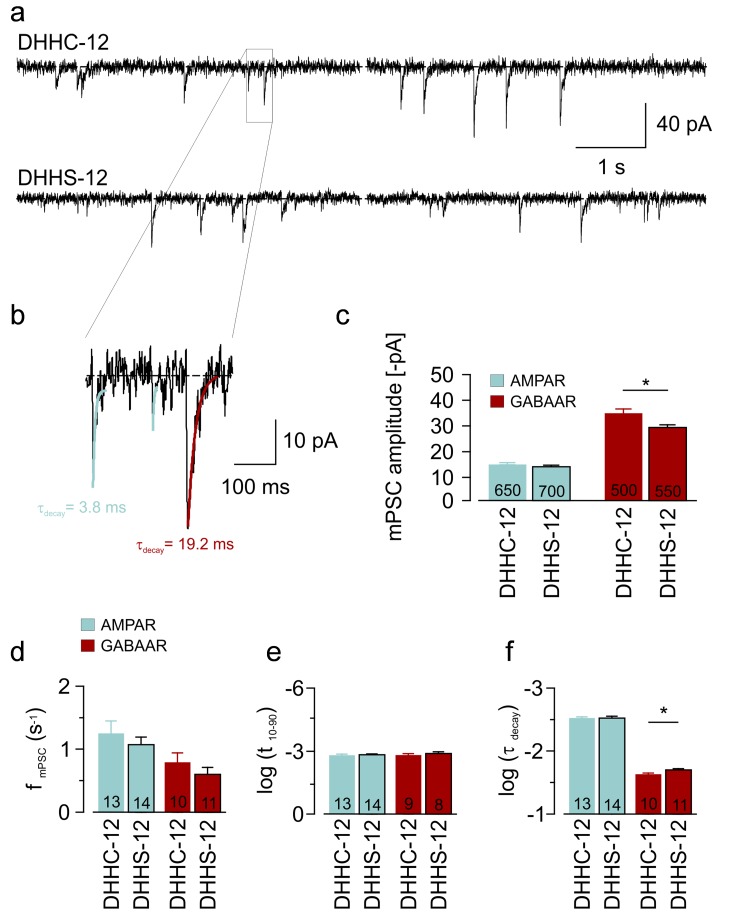
Electrophysiological analysis of GABAergic and glutamatergic mPSCs.(a) Example traces showing mPSCs recorded from DHHC-12– and DHHS-12–expressing neurons (identified using bicistronic mCherry expression). AMPAR- and GABAAR-mediated mPSCs were distinguished according to fast (AMPAR) and slow (GABAAR) decay kinetics. (b) The zoomed region of a recording from a DHHC-12–expressing neuron illustrates exponential fits of the different decay time constant (gray, AMPAR, τ = 3.8 ms; red, GABAAR, τ = 19.2 ms). (c–f) Quantification of amplitude, frequency, rise times (10–90), and decay time constants of AMPAR- and GABAAR-mediated mPSCs in DHHC-12– or DHHS-12–expressing neurons. Number of quantified events or neurons are given in parentheses.